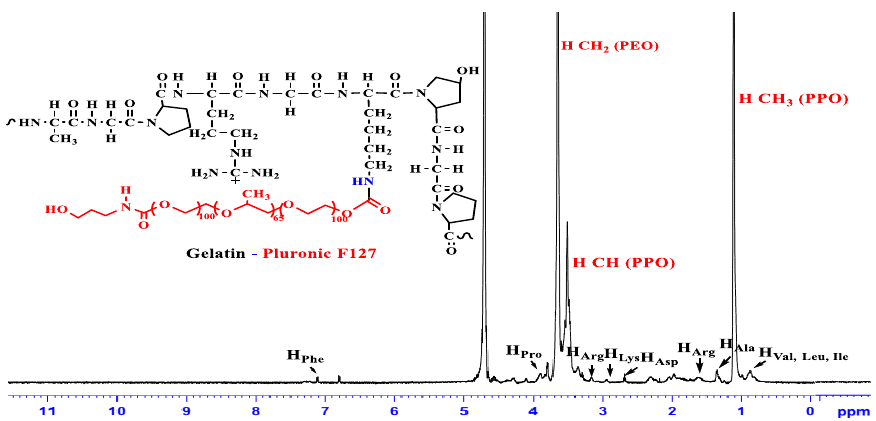
Figure 1. Synthetic scheme of GP copolymer .